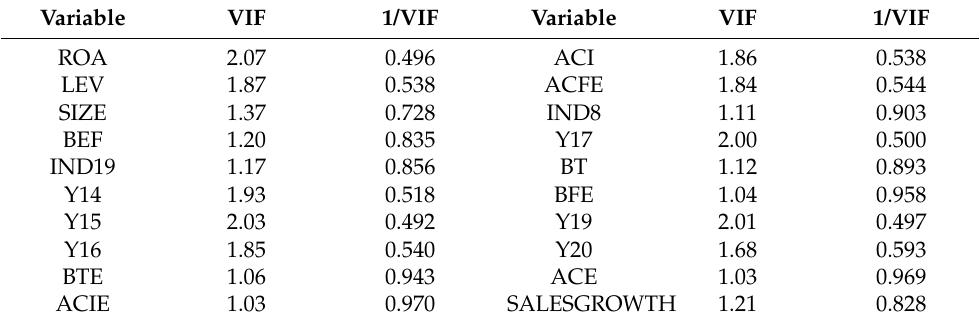
Table 6. The alignment test of the first model.